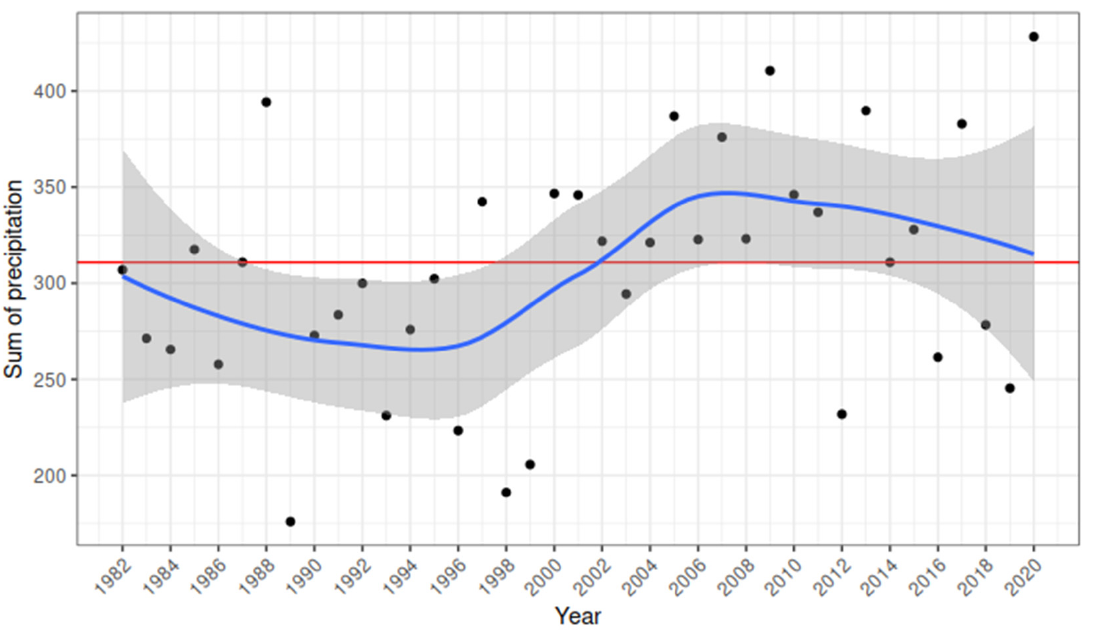
Figure 4. The relationship between total precipitation during the growing season and the year of observation.